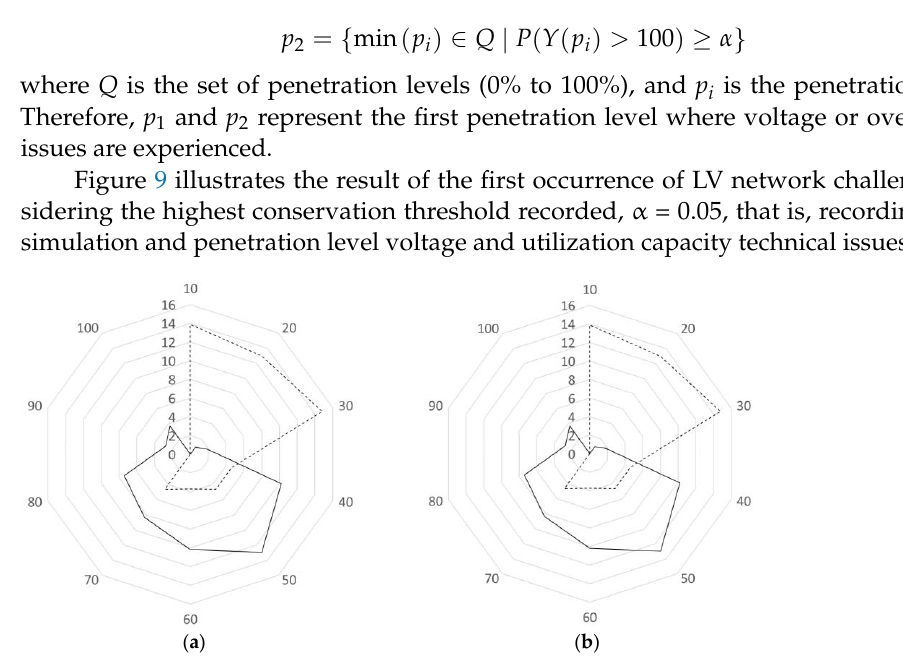
Figure 9. First occurrence of voltage ( a ) and utilization ( b ) capacity issues in downstream (fixed) and upstream (dashed) scenarios (α = 0.05) .